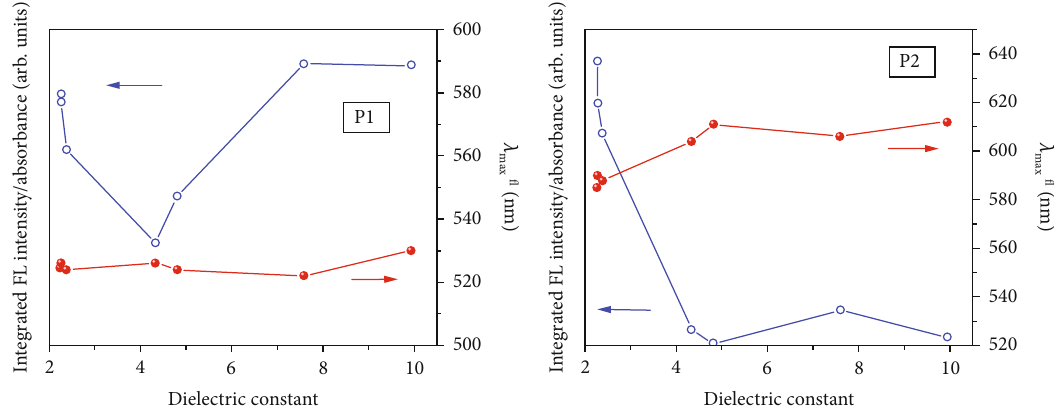
Figure 9: Plots of absorbance-corrected, integrated fl uorescence intensity (excited at the corresponding absorption maximum) and maximum emission wavelength of P1 and P2 as very dilute solutions (maximum absorbance: ca. 0.1) in di ff erent solvents as a function of the dielectric constant of the solvent. Note that hexane, DMF, and DMSO are excluded.